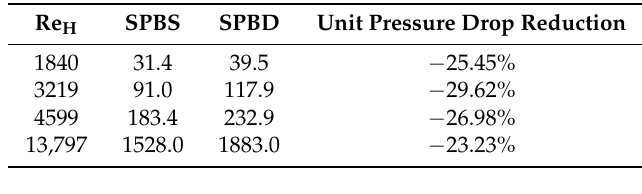
Table 4. The unit pressure drop of the structured packed beds with smooth or dimpled spheres at N = 1.15 (Pa · m − 1 ).